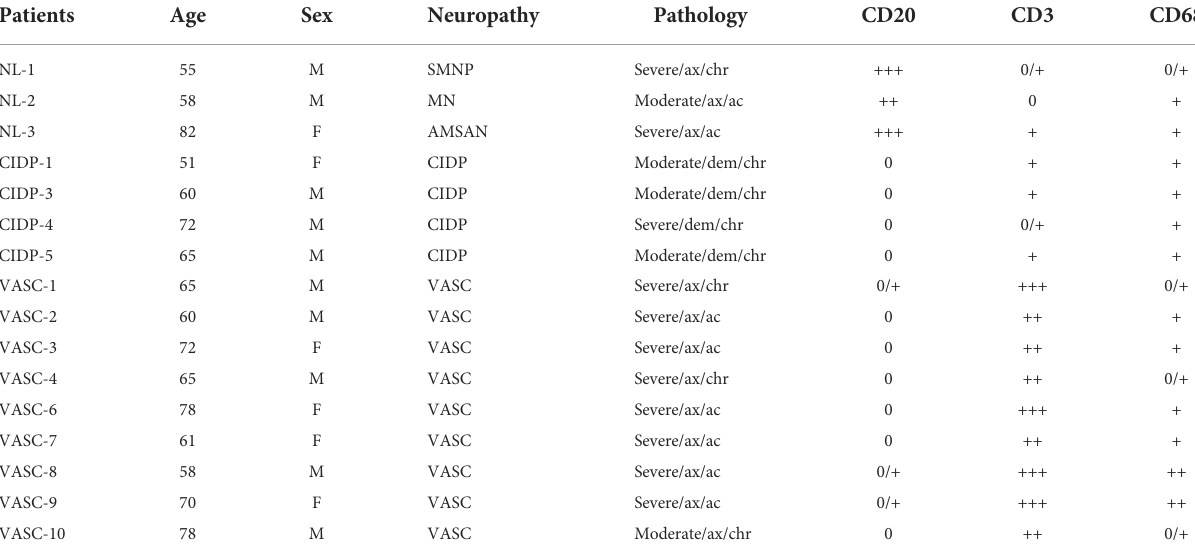
TABLE 2 Characteristics of patients included in gene expression